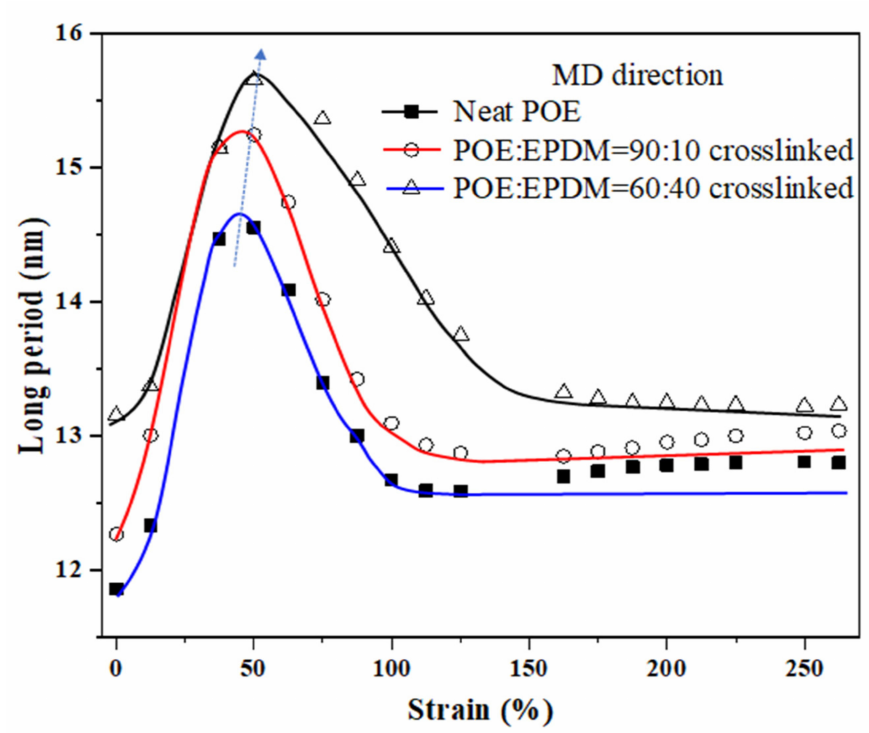
Figure 6. The SAXS profiles in the MD direction for the neat POE, crosslinked POE:EPDM = 90:10, and crosslinked POE:EPDM = 60:40 at different strains. In the stretching direction, the peak position of the long period is located at higher strains for the crosslinked blends.